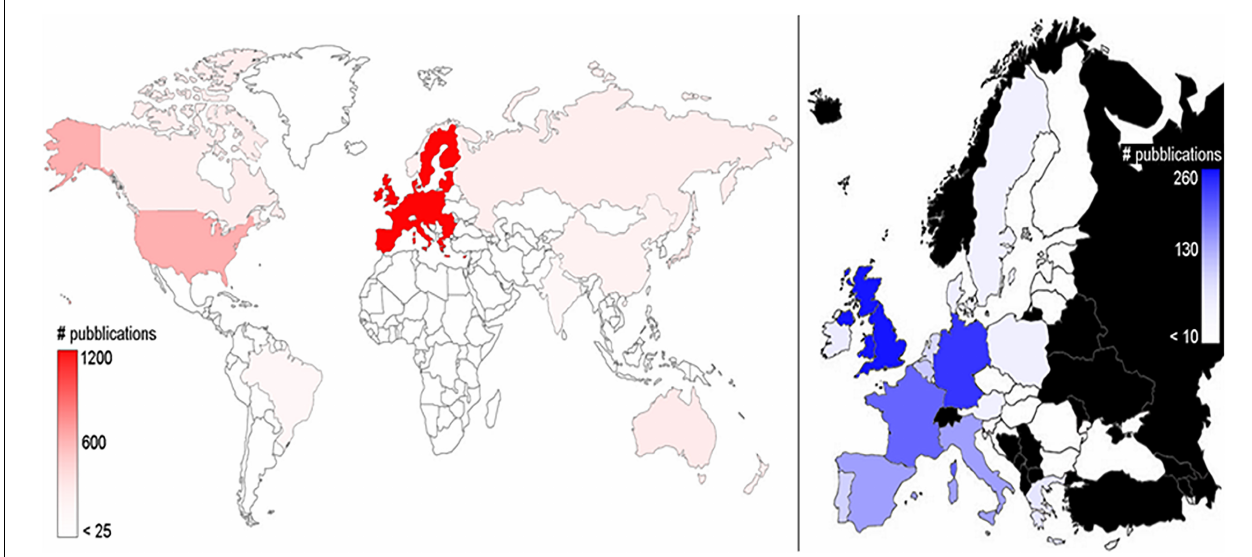
FIGURE 2 | Geographic distribution of the publications on deep-sea biodiversity (1993–2019). Illustrated is the world distribution (left panel) and the European Union distribution ( right panel ; in black are countries that do not belong to the EU, for which results are not shown). The color intensities are related to the number of publications, as highlighted in the lateral